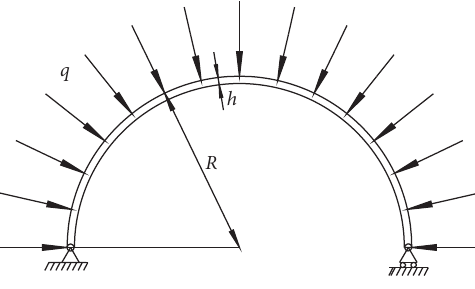
Figure 4: Mechanical model of RBA.